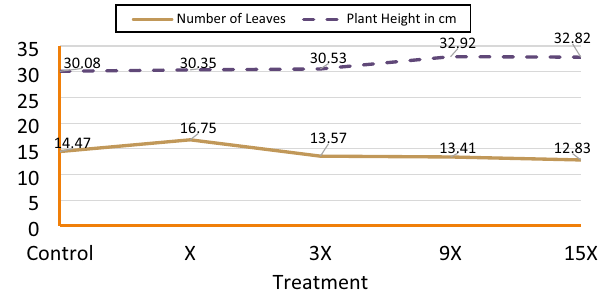
Figure 2. Plant growth responses to different metal